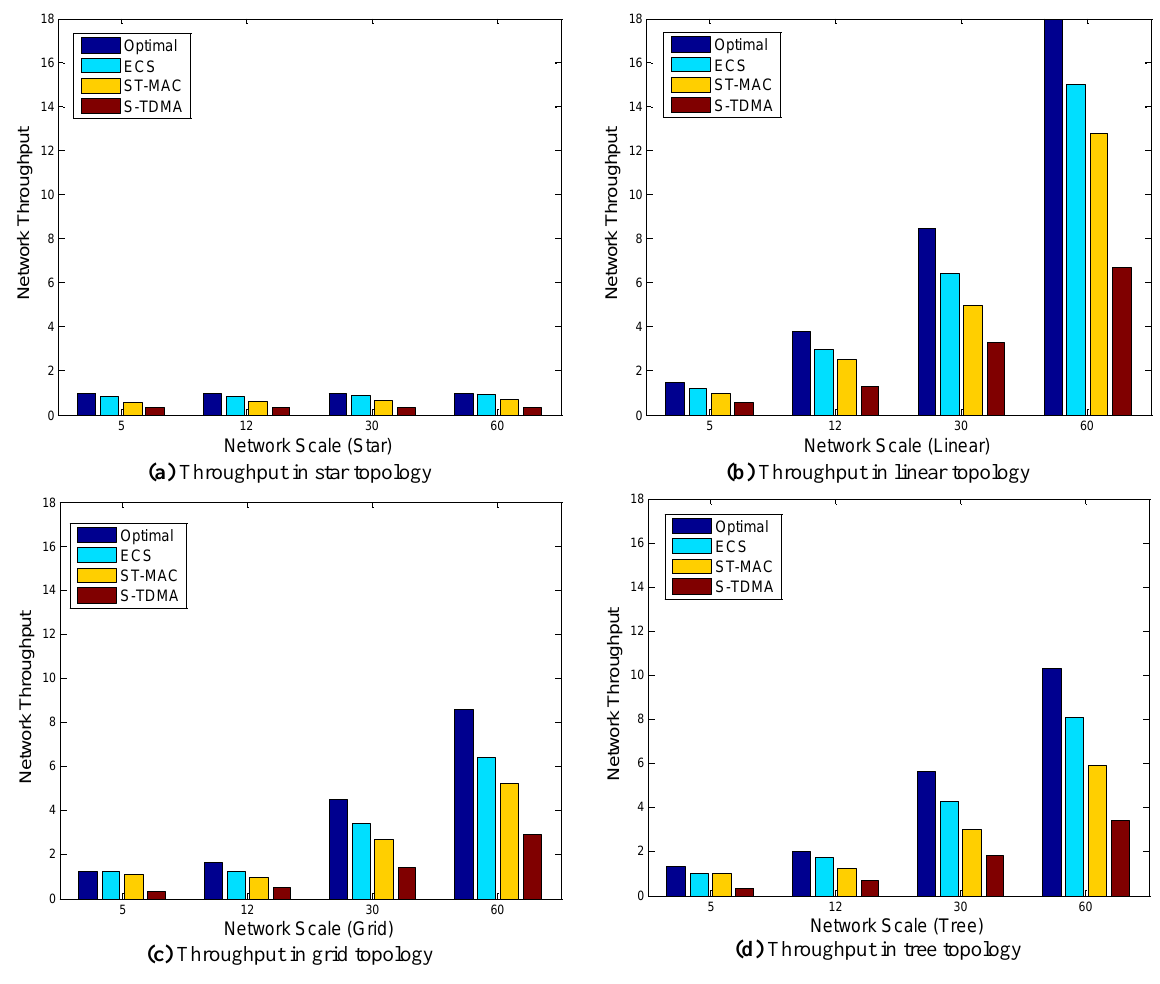
Figure 7. Network throughput in different topologies: (a) Star, (b) Linear, (c) Grid, (d)